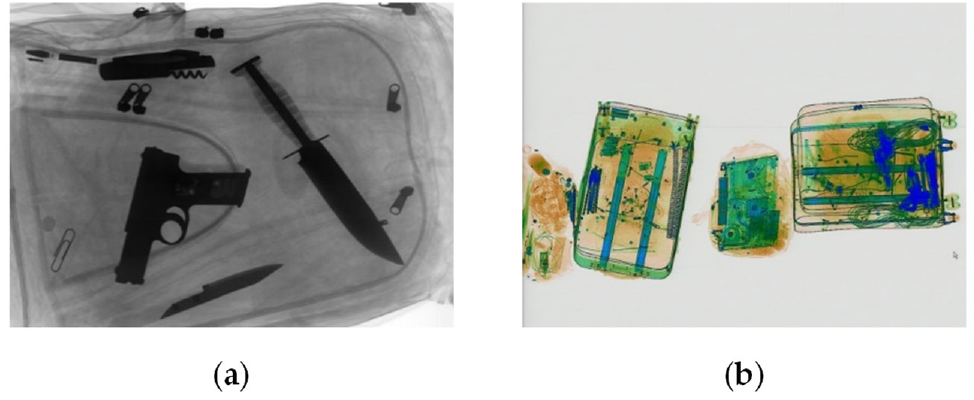
Figure 6. Example images: ( a ) GDXray dataset; ( b ) SIXray dataset. The SIXray dataset contains more than one million X-ray images, including six types of targets, i.e., guns, knives, wrenches, pliers, scissors, and hammers, and 8929 marked images containing these targets. The stacking randomness of the target objects is quite large in the SIXray dataset, the image backgrounds are complex, and there are instances of severe overlap and occlusion. Example images from the SIXray dataset are shown in Figure 6b.